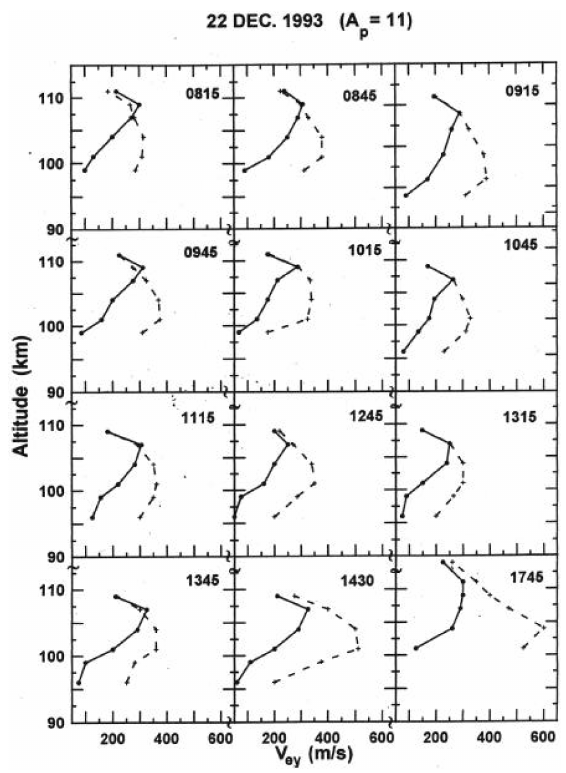
Fig. 1. Daytime altitude profiles of V ey on 22 December 1993. The solid curves correspond to the uncorrected V ey values (without in- cluding turbulence effects), while the dashed curves represent the corrected V ey values obtained after including the effects of turbu-